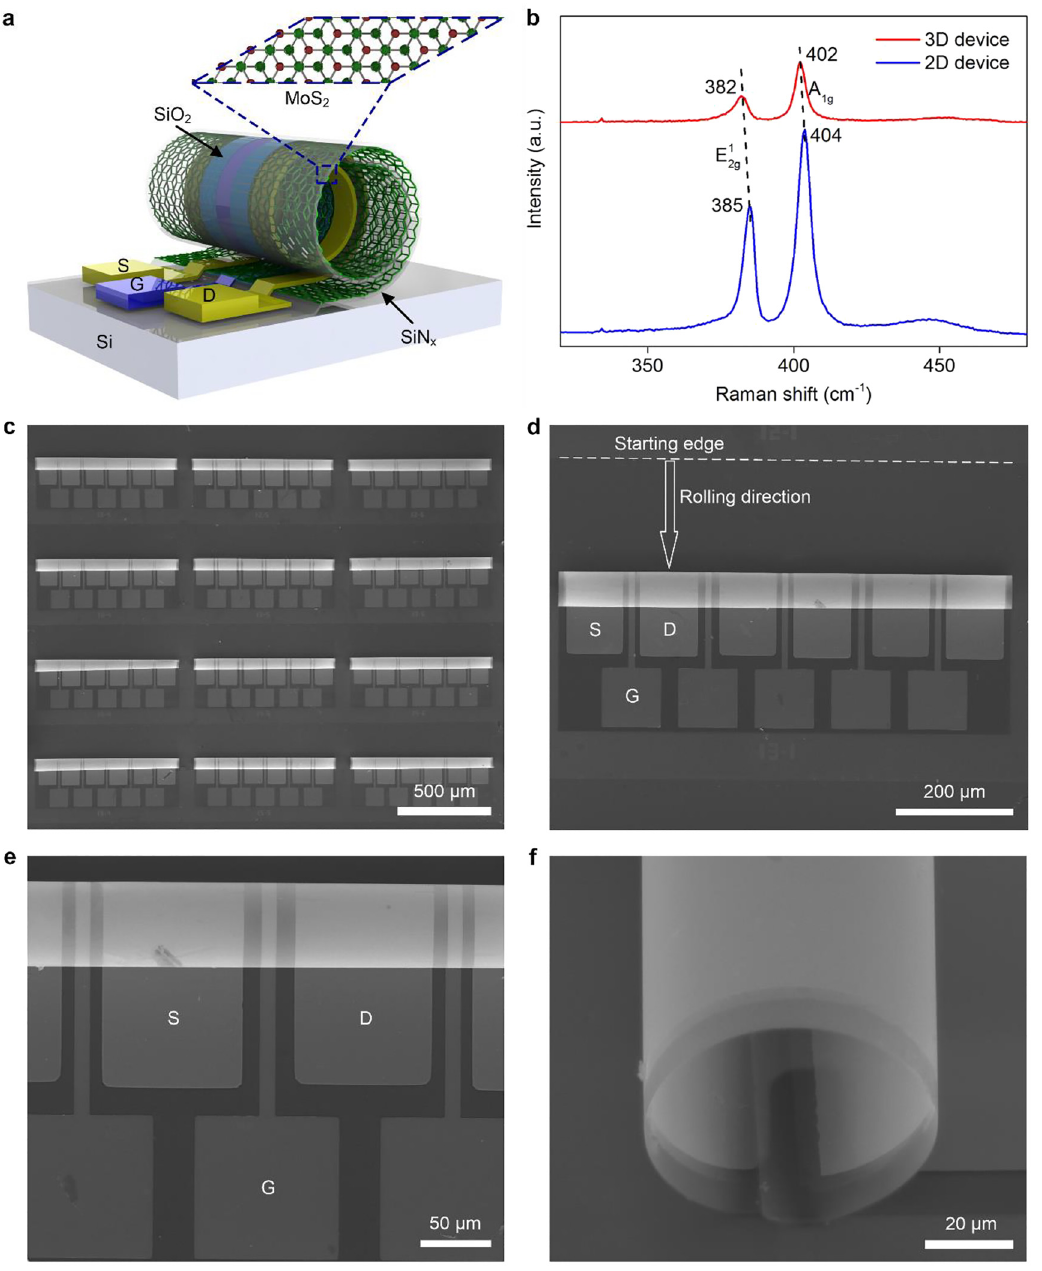
(a)Schematic3DviewofthetubularMoS 2 FET;(b)Ramanspectraofthe3DMoS 2 FETand2DMoS 2 FET;(c)thearrayof3DMoS 2 FETmicrotubes; (d) the SEM microimage of a 3D MoS 2 FETs microtube; (e) the zoomed-in image of the 3D MoS 2 FET; (f) the side view of a 3D MoS 2 FET with one rolled-up winding. 2D, two-dimensional; 3D, three-dimensional; FET, fi eld-effect transistor; MoS 2 , molybdenum disul fi